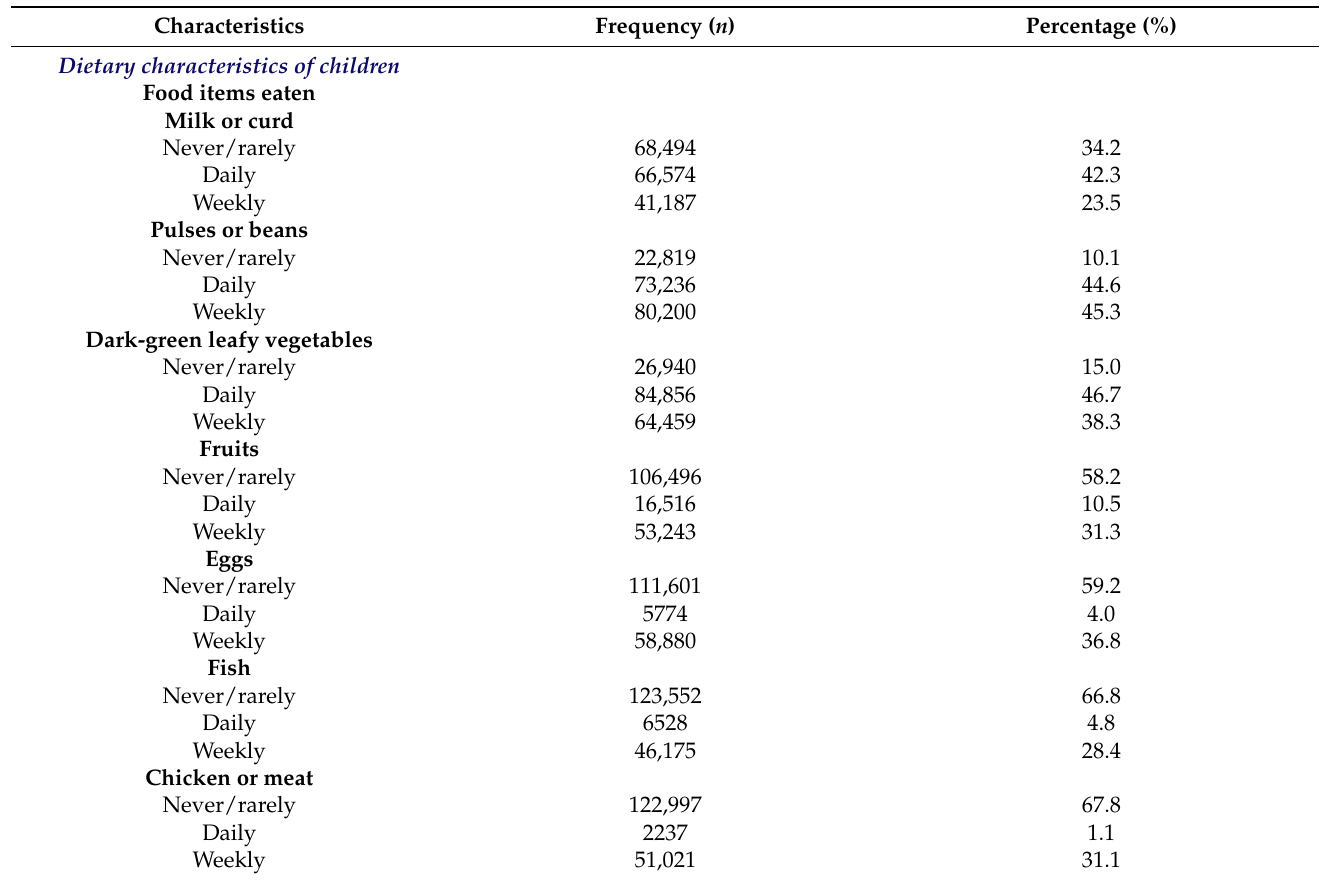
Table 2. Dietary characteristics of the sample population ( n =